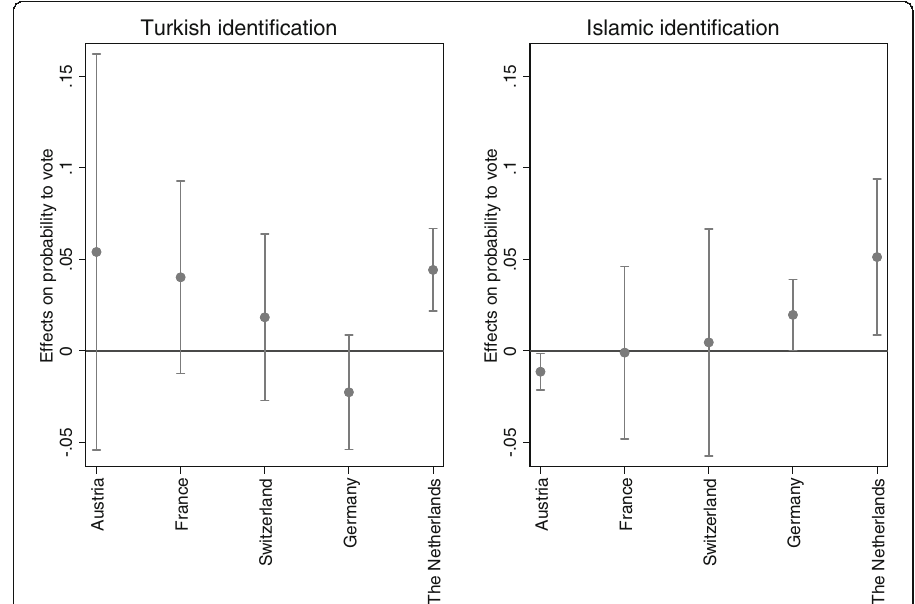
Fig. 2 Effects of Turkish and Islamic identifications on local voting according to country (TIES surveys 2007/2008). These graphs show the marginal effects of Turkish and Islamic identification on the probability to vote locally (vertical axis) for different countries (horizontal axis)